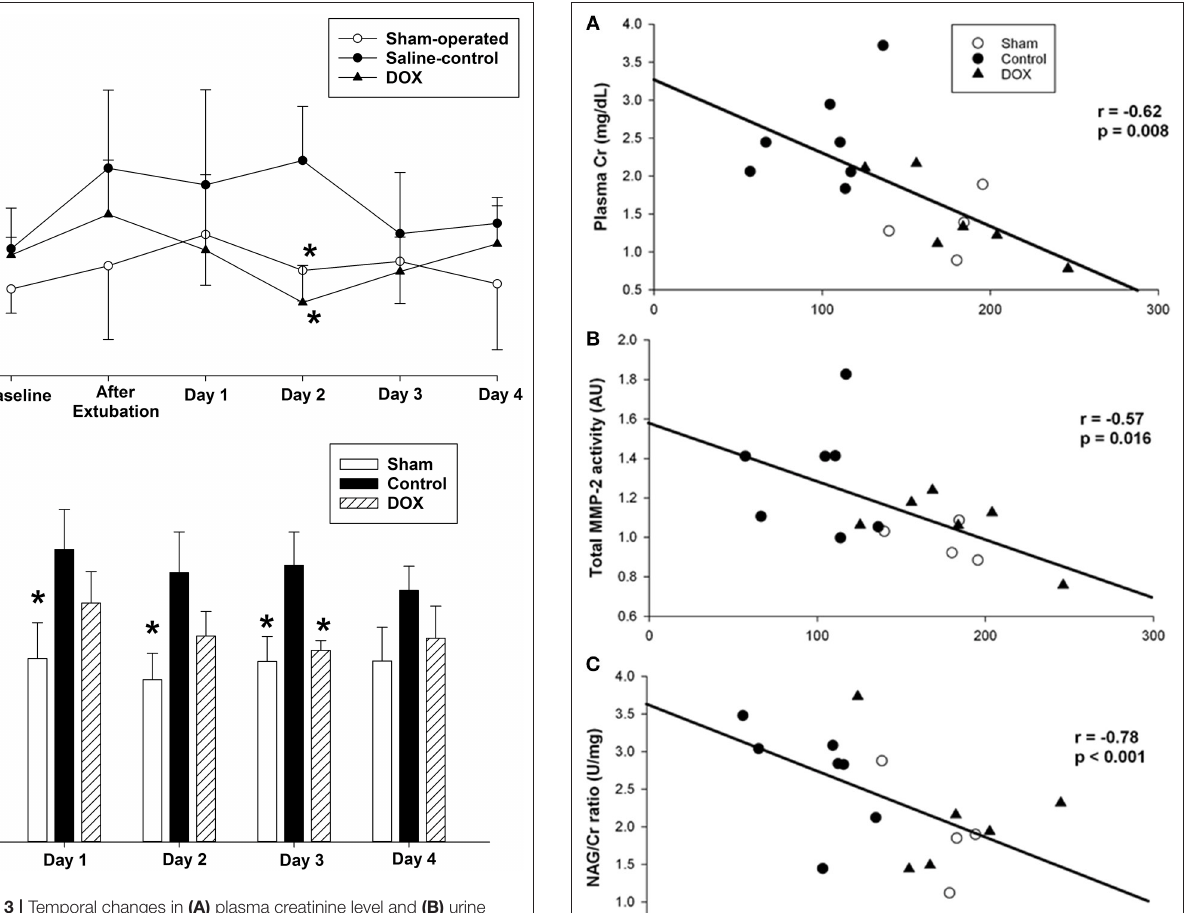
FIGURE 3 | Temporal changes in (A) plasma creatinine level and (B) urine NAG/Cr ratio after hypoxia and during recovery of sham-operated, saline-control and DOX groups. All values represent mean ± SEM. * p < 0.05 vs. saline-controls at current time point (two-way repeated measures ANOVA).